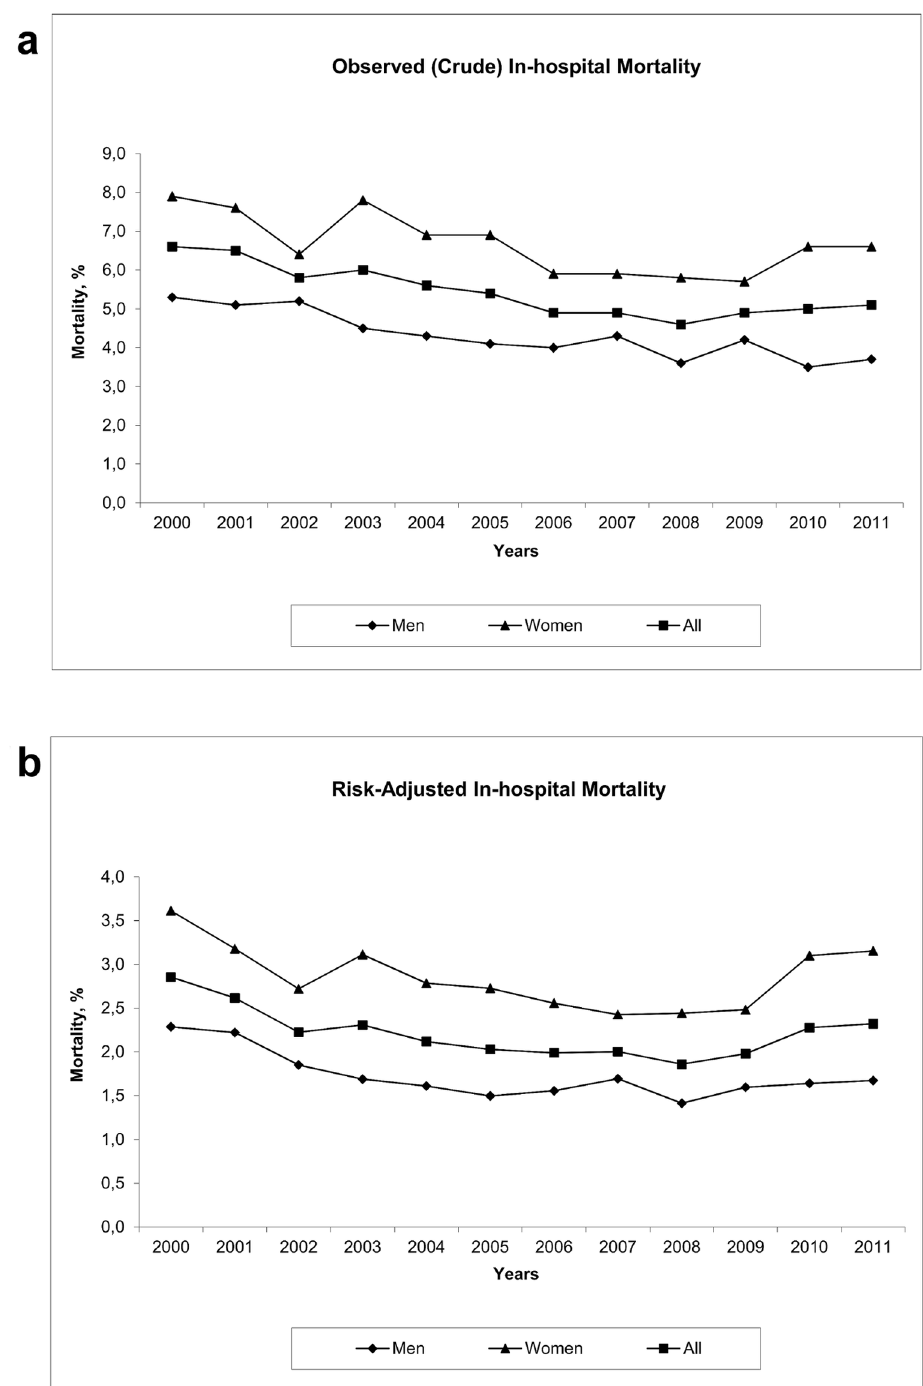
Fig 1. In-hospital mortality among patients with ischemic stroke between 2000 and 2011. A, Observed (crude) mortality. B, Risk-adjusted mortality was determined with the use of logistic regression models to adjust for age, sex, initial stroke severity, and the number of